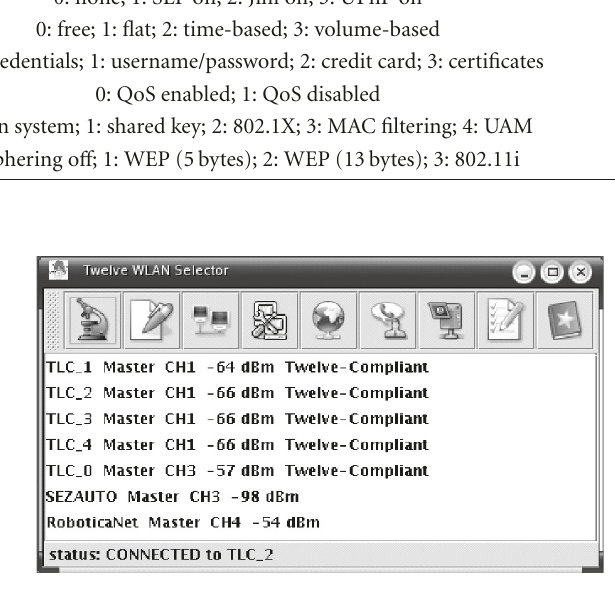
Figure 2: TWS: list of surrounding APs.